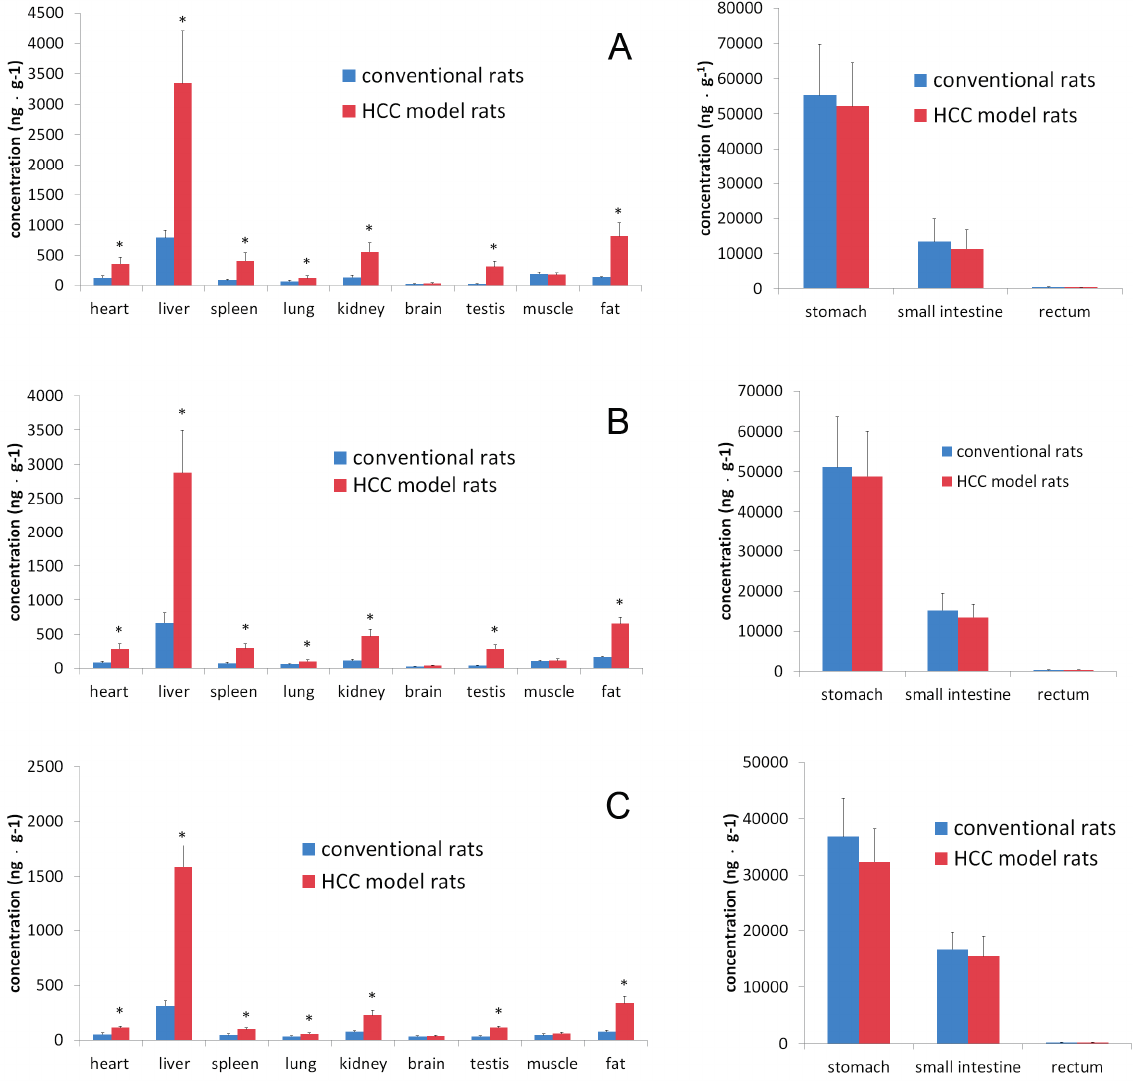
Figure 3. The concentration of caudatin in tissues after oral administration at a dose of 20 mg/kg in conventional and HCC rats. ( A ) 0.5 h; ( B ) 1.0 h; ( C ) 3.0 h. Significantly different from the conventional rats (*, p <